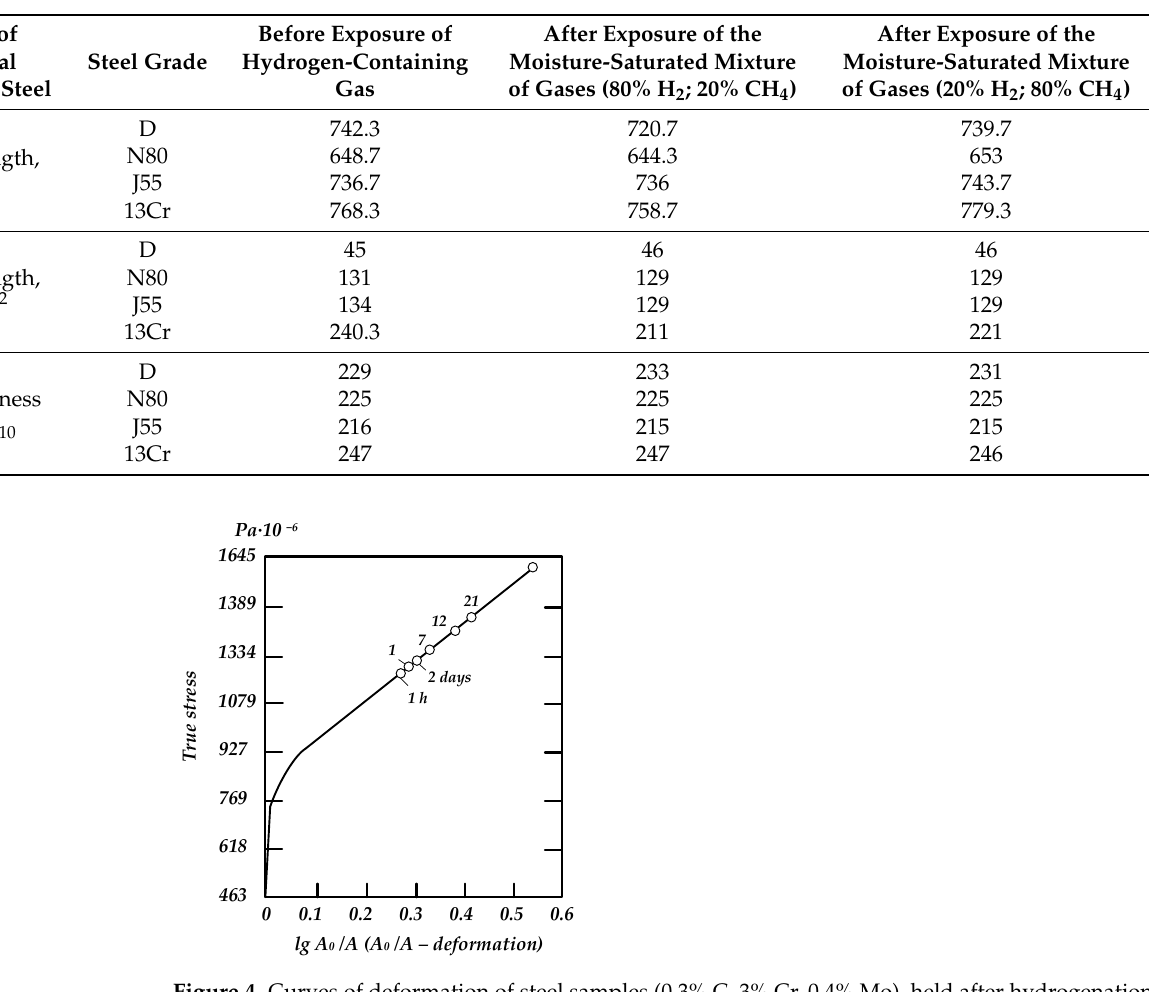
Table 5. Mechanical properties of the studied steel grades before and after exposure to an aggressive environment with different hydrogen concentrations [49].